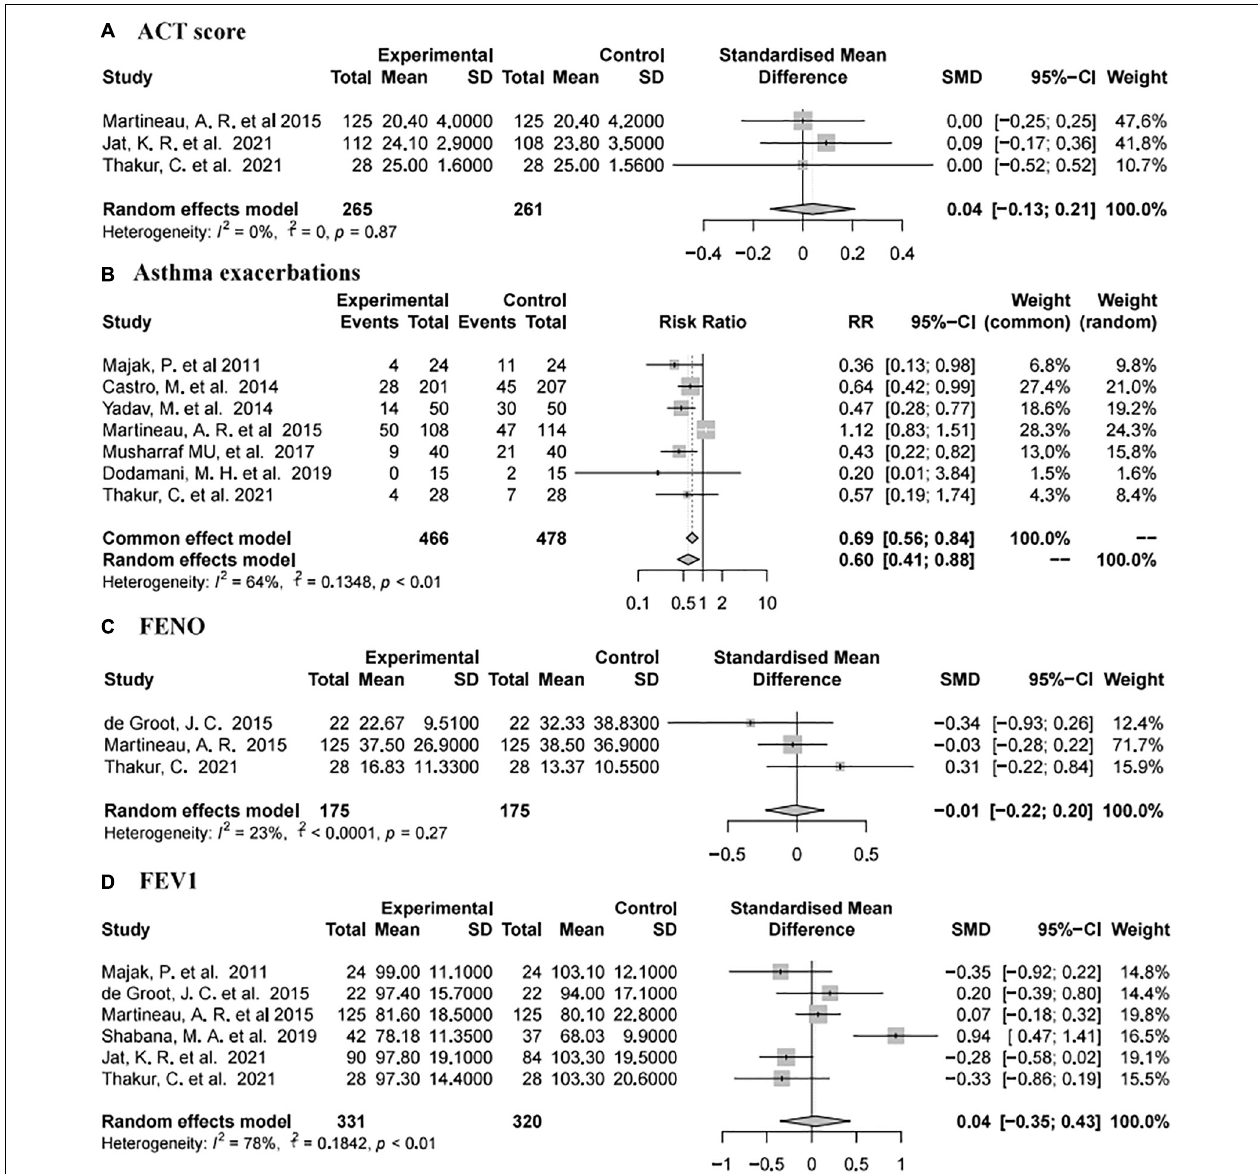
FIGURE 4 | Forest plot random effect model for vitamin D supplementation for various